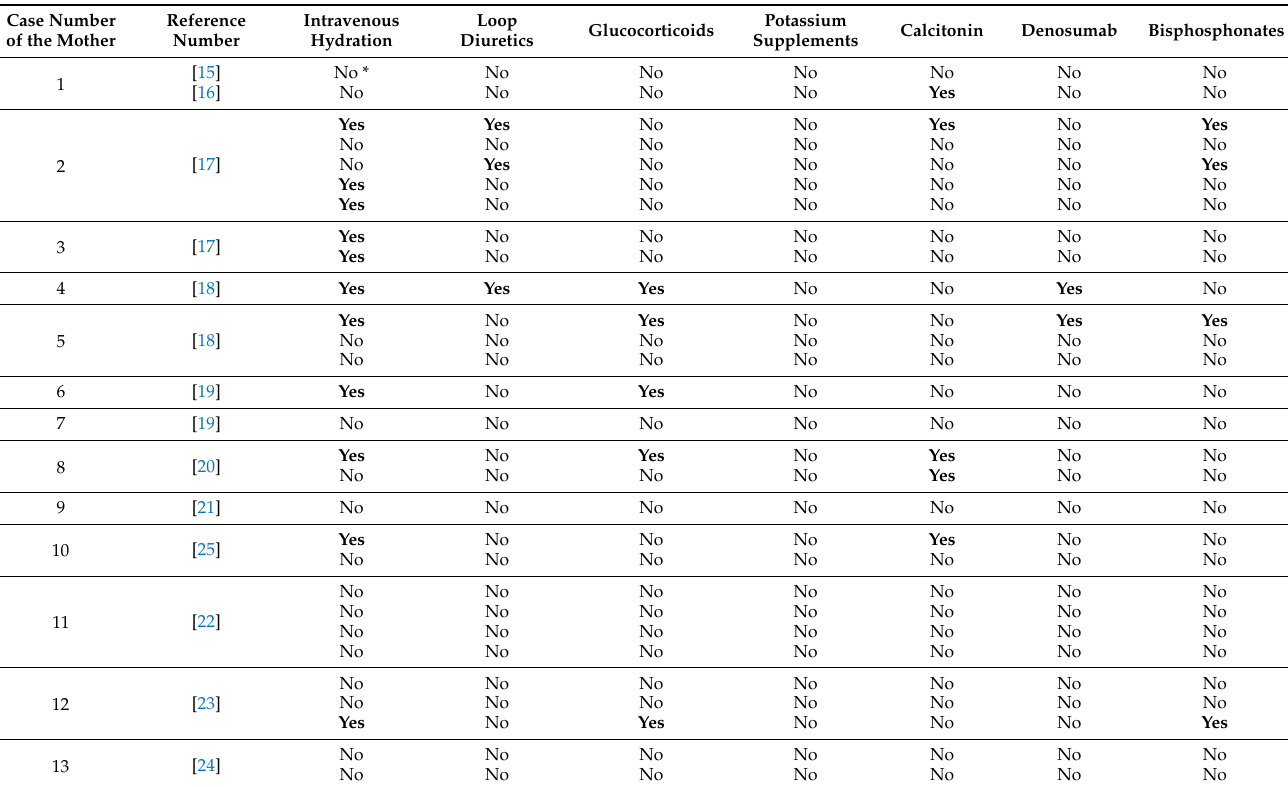
Table 4. Specific drug treatments of women with pathogenic CYP24A1 mutations